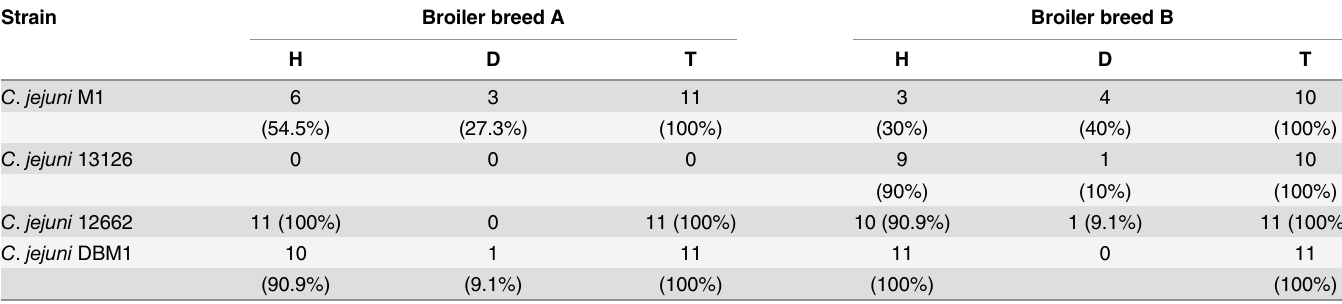
Table 2. Colonisation dynamics of C . jejuni strains in two commercial broiler lines at 4DPI.